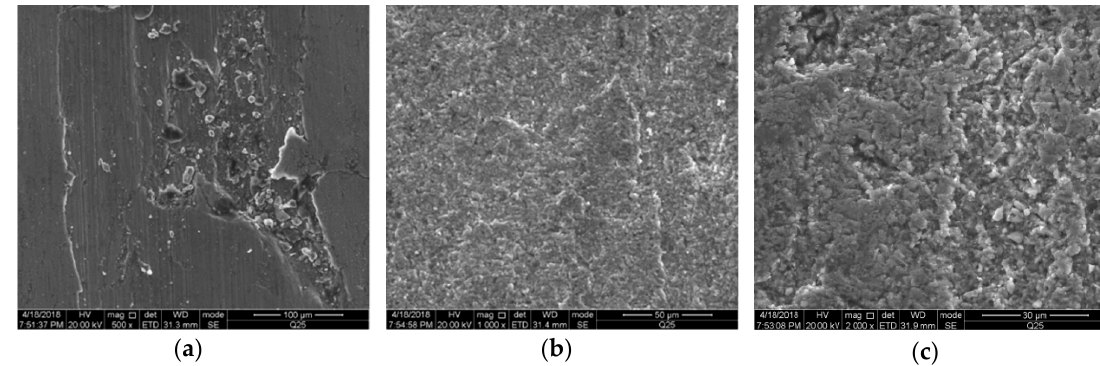
Figure 17. The suction end surface topography of the orbiting scroll after the compressor with DLC film is running: ( a ) 500 times; ( b ) 1000 times; ( c ) 2000 times.